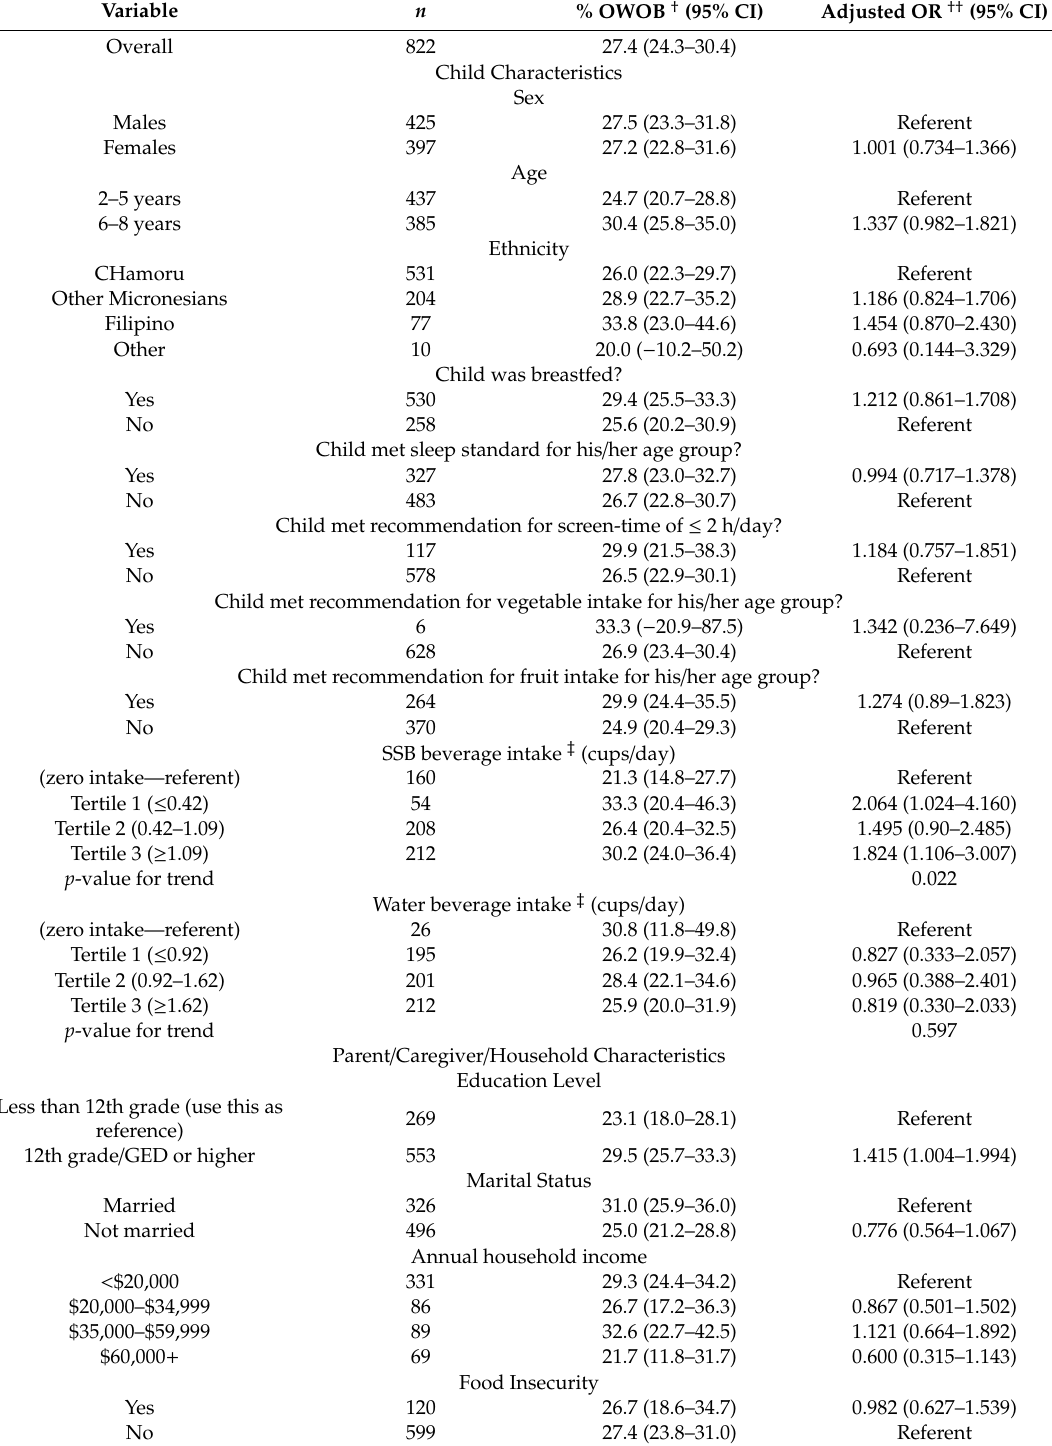
Table 3. Prevalence and Odds of OWOB among child participants from Guam in the Children’s Healthy Living (CHL)